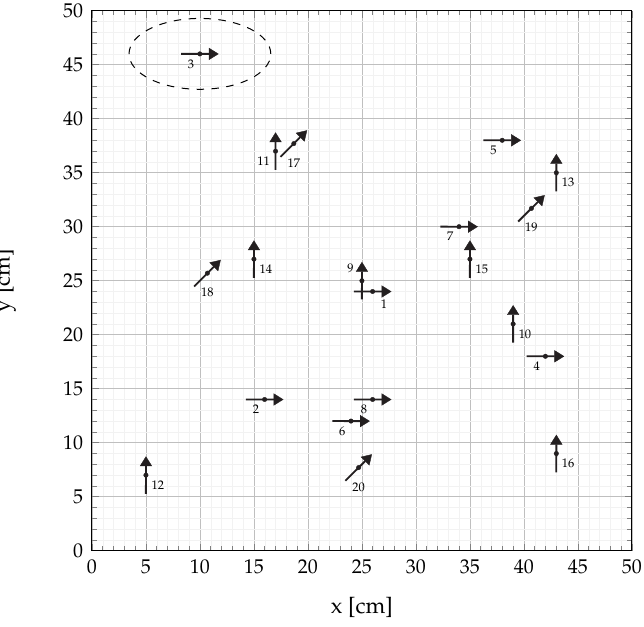
Figure 9. Position-orientation-pairs of the sensor used for testing the localization